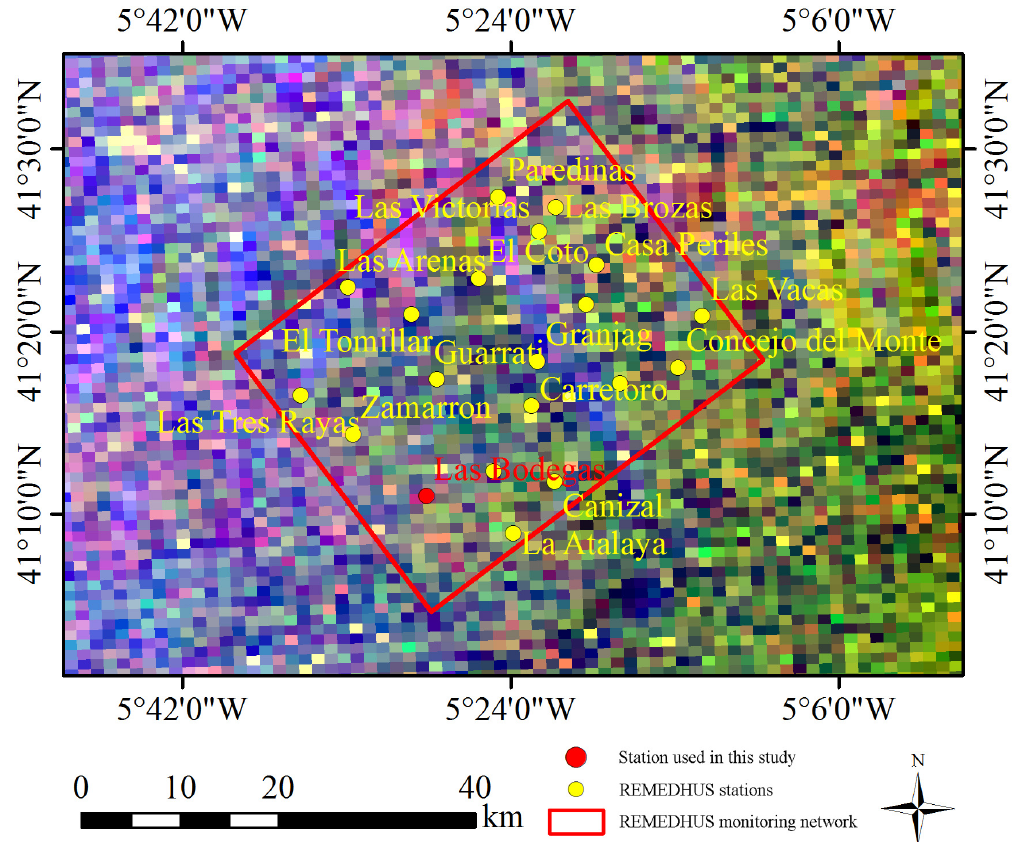
Figure 1. Geographical location of the REMEDHUS monitoring network and the background indicates the Sentinel-1A dual-polarization data (VV, VH, and VV polarizations have been used for red, green, and blue channels, respectively.